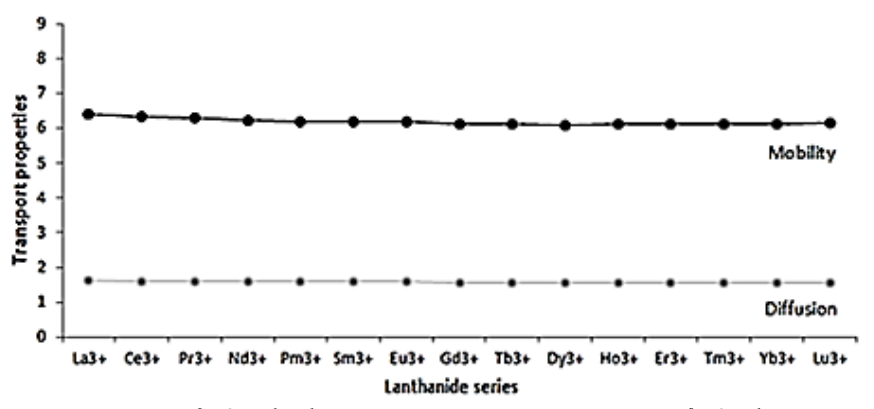
Fig. 4: The mobility (×10 −8 m 2 V −1 s −1 ), and diffusion coefficient (×10 −9 m 2 s −1 ) of lanthanide